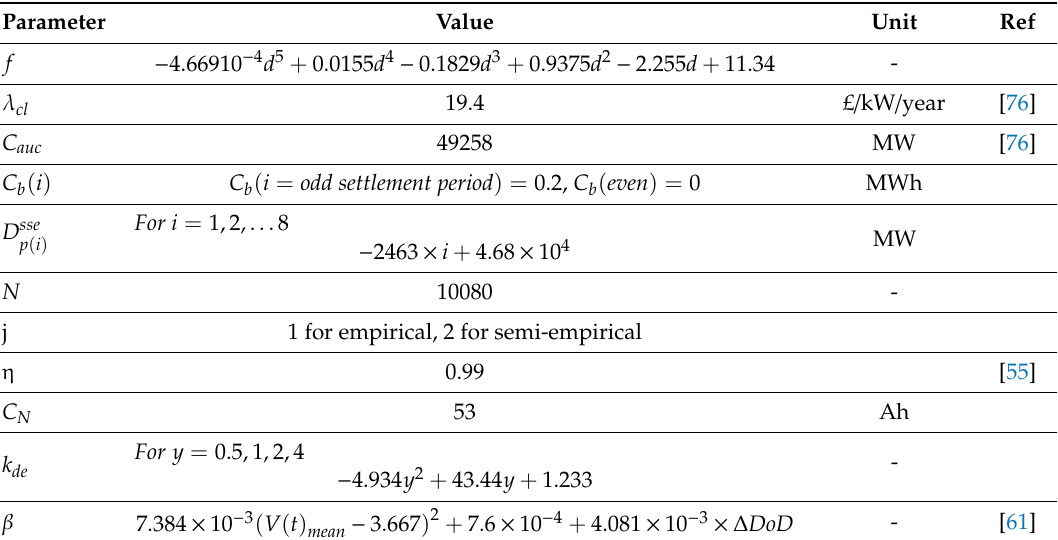
Table A1. Parameter values used in this